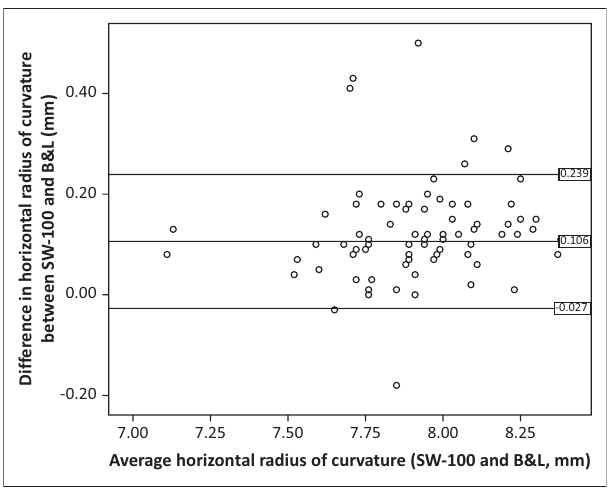
Note: The mean difference or bias is indicated by the middle line; the 95 % limits of agreement are the lines on both sides of the midline. FIGURE 1: Differences in horizontal radius of curvature between the SW-100 and Bausch & Lomb keratometers, plotted against the mean horizontal radius of curvature.